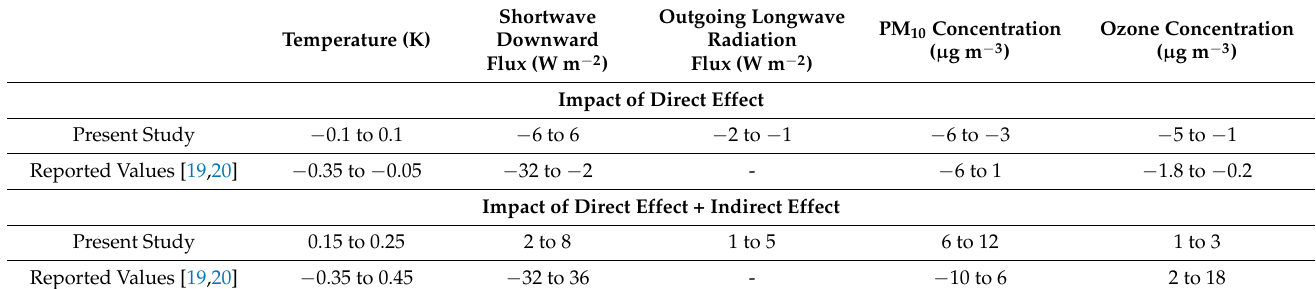
Table 1. Quantitative impact on both meteorological and air quality parameters for aerosol-radiation feedback (i.e., direct effect) and aerosol–radiation–cloud feedback (i.e., direct + indirect effect) for